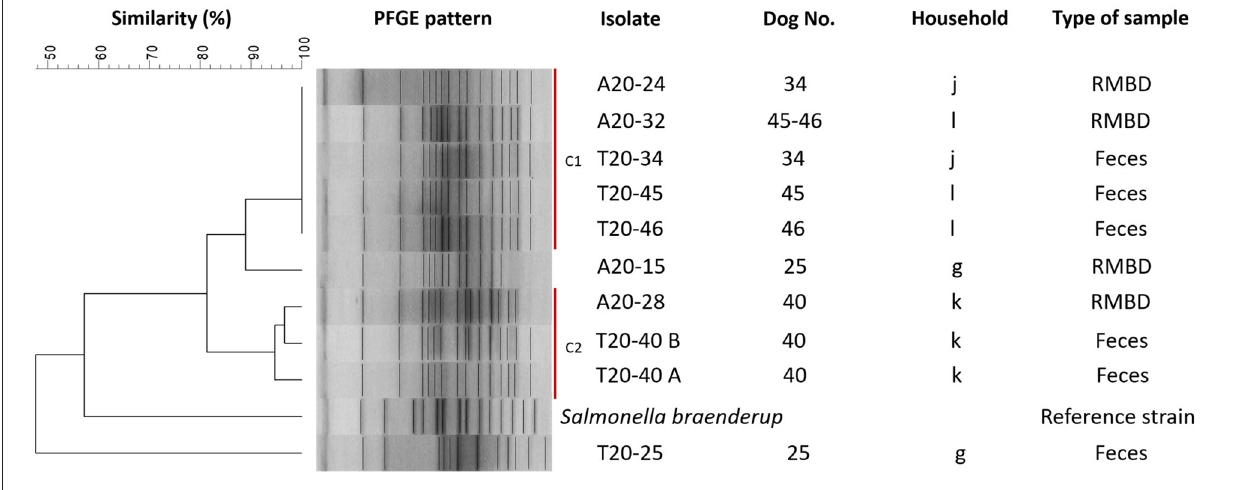
FIGURE 3 | Dendrogram of pulsed-field gel electrophoresis (PFGE) cluster analysis of ten Salmonella spp. isolates from RMBD and fecal samples from RMBD-fed dogs. PFGE was performed for Salmonella spp. with the restriction enzyme Xba I. Sample T20–40 represents two different samples from the same patient taken 1 month apart. C1, cluster 1; C2, cluster